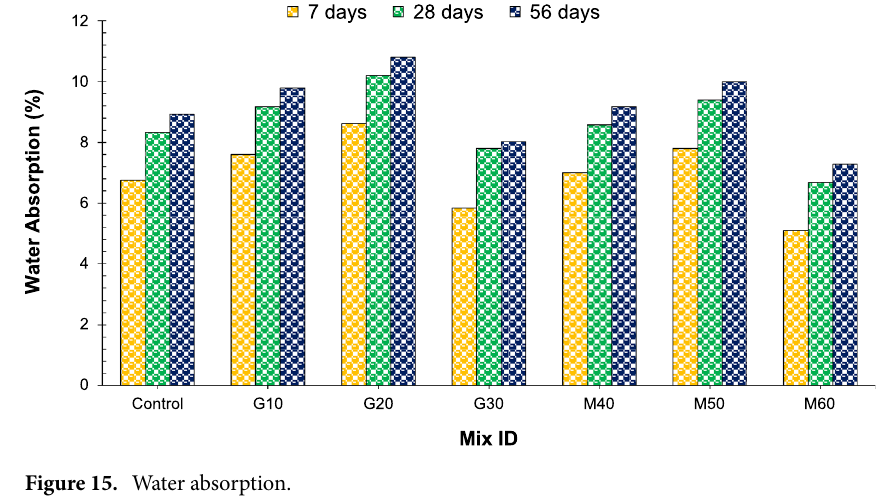
Figure 15. Water absorption.